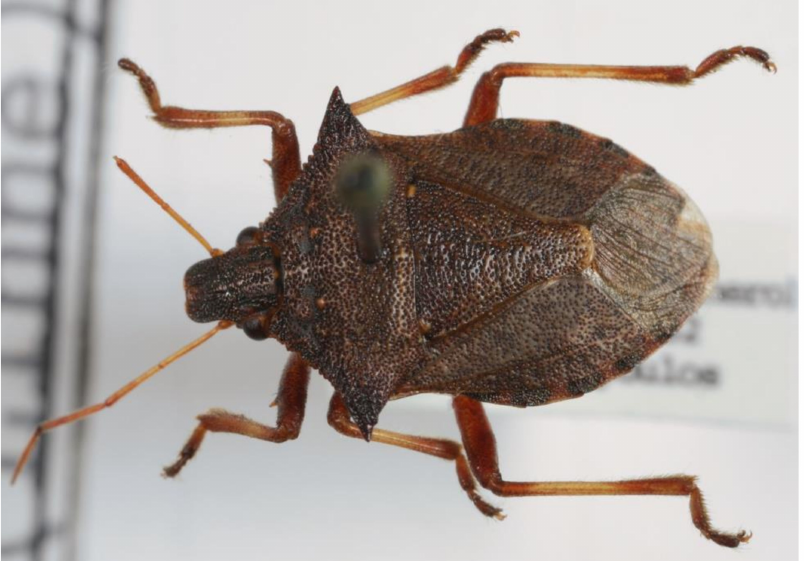
Figure 3. Picromerus bidens (Collector S. Drosopoulos, Vernon Mt.-Kalo Nero 30.VII.1982, posited in S. Drosopoulos historical collection. Photo A. Tsagkarakis 12.VIII.2022).